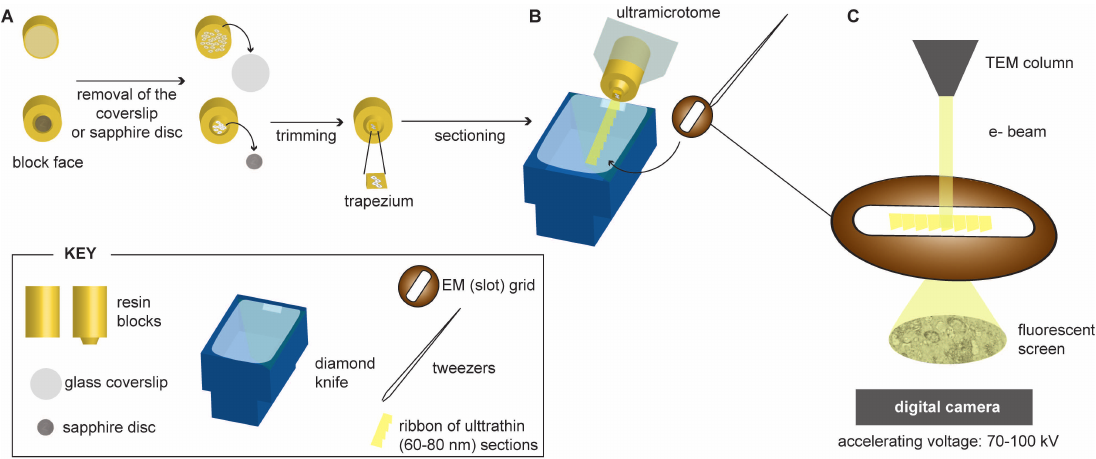
Figure 3. Schematic representation depicting the post-processing steps prior to the analysis of virus-infected cells by conventional-EM (“plastic-EM”). ( A ) Virus-infected cells embedded into a plastic resin are sectioned with an ultramicrotome: the resin block containing the embedded virus-infected cells must be trimmed to a trapezium-like shape with an average size of approximately 200 (cid:2) 250 µ m prior to its sectioning with a diamond knife equipped with a water shank; ( B ) The obtained ultrathin sections (60–80 nm, in yellow) float on the water surface from where the section ribbon can be mounted onto a formvar-coated EM grid; ( C ) After contrasting with heavy metals, the cell sections can be examined with a conventional transmission electron microscope (TEM) operated at accelerating voltages between 70–100 kV. In brief, an electron beam is generated (by a thermionic or a field emission gun) and accelerated under vacuum. The electrons are then transmitted through the cell sections. After passing through the specimen, scattered electrons are focused by electromagnetic lenses and magnified onto an imaging device such as a fluorescent screen or recorded with a digital camera (CCD, charged-coupled device, or a CMOS, complementary metal-oxide semiconductor). The diagram of the TEM-working principle shown on the right is adapted from Briggman and Bock